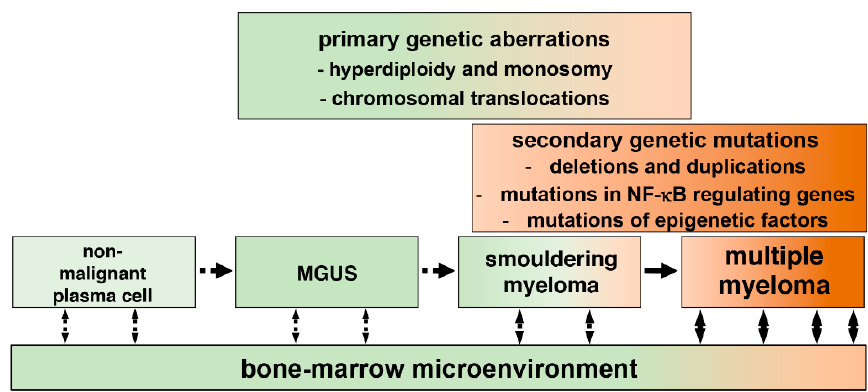
Figure 1. Development of multiple myeloma (MM) from plasma cells. Progression of MM from post-germinal center plasma cells to symptomatic myeloma occurs through intermediate MGUS (monoclonal gammopathy of undetermined significance), and SMM (smouldering MM) stages. Plasma cells associated with MGUS and SMM may display chromosomal abnormalities, which trigger cellular transformation. Cancerous plasma cells acquire additional, secondary genetic mutations, which support tumor growth by activating key signaling pathways in malignant cells. Finally, cell–cell communications, which involve physical interactions between cancerous cells and cancer-associated stromal cells, and secretion of cytokines and other soluble factors, promote survival and proliferation of myeloma cells within the bone marrow